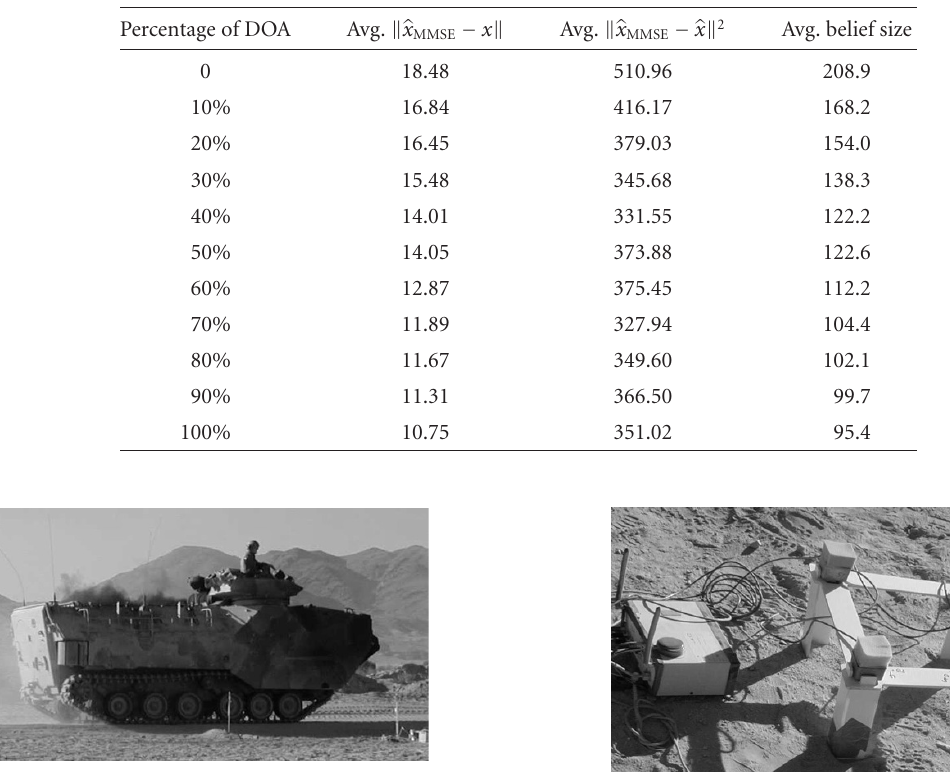
Table 4: Tracking performance versus percentage of DOA sensors.